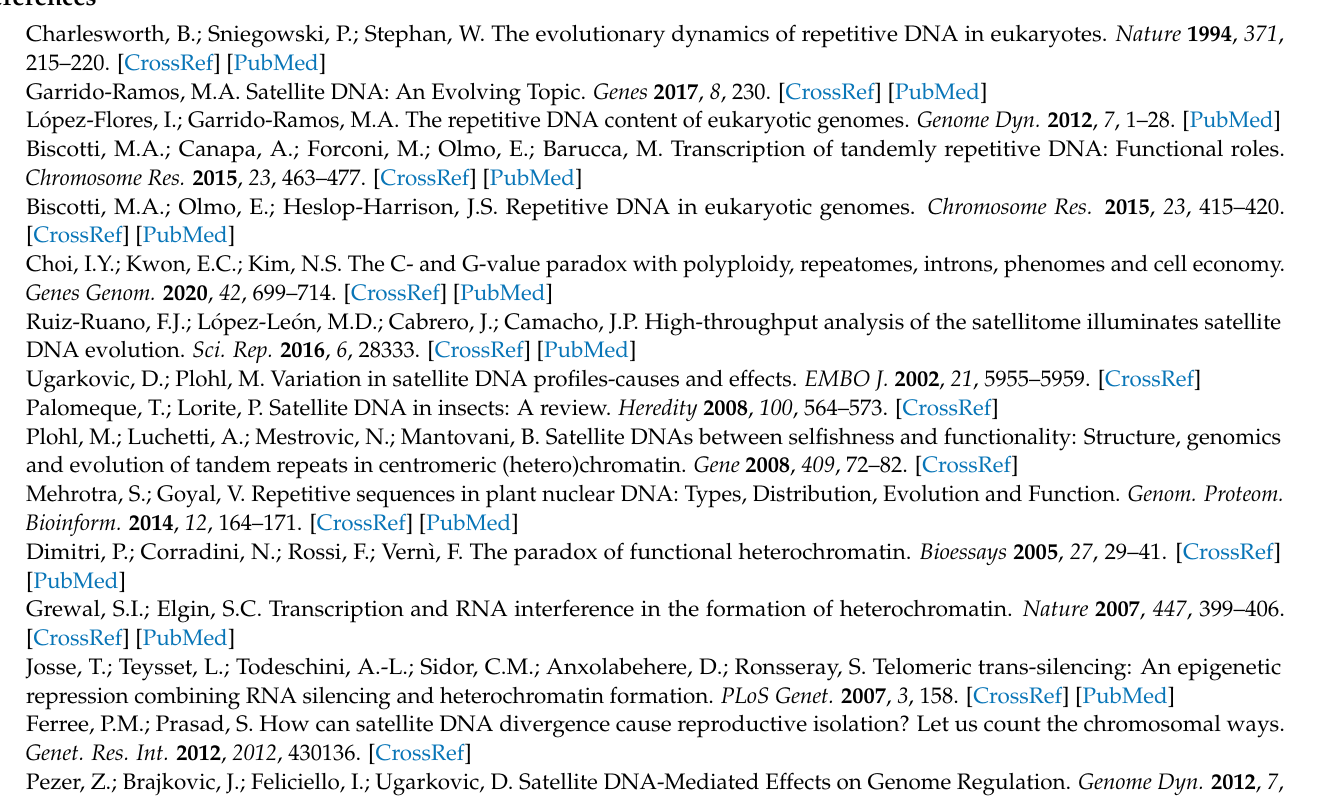
Figure S2: Correlation between the tandem structure index and the fold-change of satDNA family abundance among T. occidentalis assembled genome and T. occidentalis genome; Figure S3: Presence and abundance of T. aquitania satDNA families across species of the family Talpaidea; Table S1: T. aquitania satDNA families consensus sequences; Table S2: List of oligos used to localize by FISH the repeat DNA sequences of T. aquitania ; Table S3: Excel file containing data about T. aquitania satDNA families abundance in Talpidae